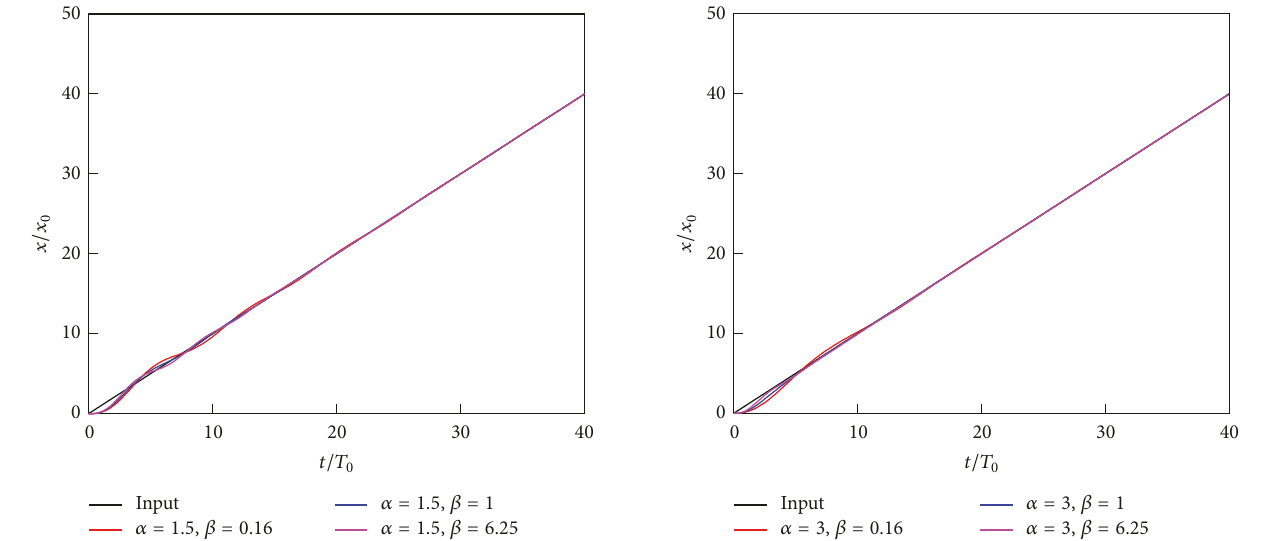
Figure 27: Response in the time domain ( 𝛼 = 3, 𝛽 = 0.16, 1,6.25 ).